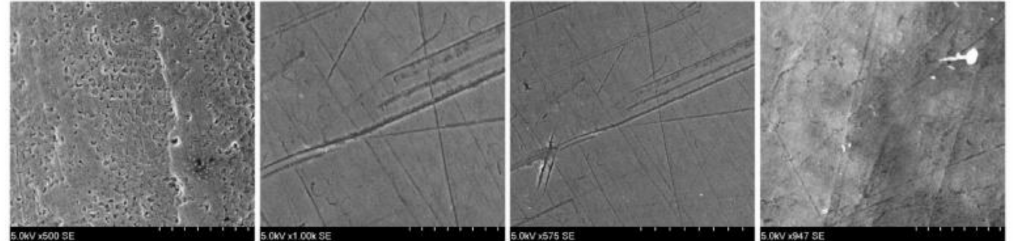
Figure 3. Microscopic appearance of the enamel before treatment 6.0